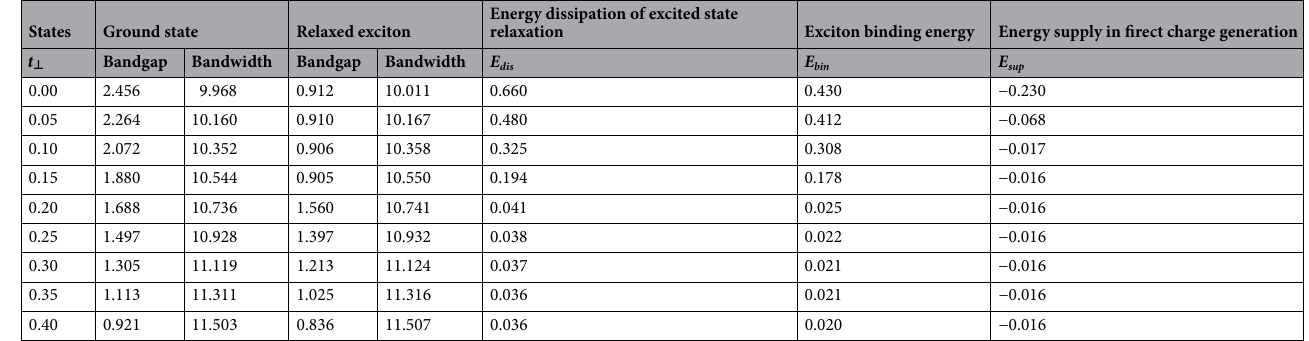
Table 1. Parameters of organic stacking system with different intermolecular coupling strengths. (Unit: